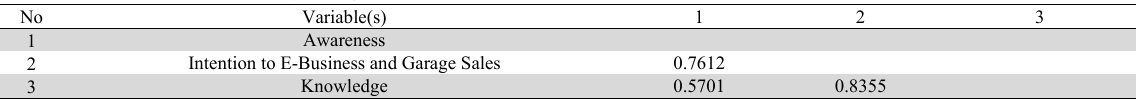
Results the Discriminant Validity using Heterotrait-Monotrait Ratio (HTMT)